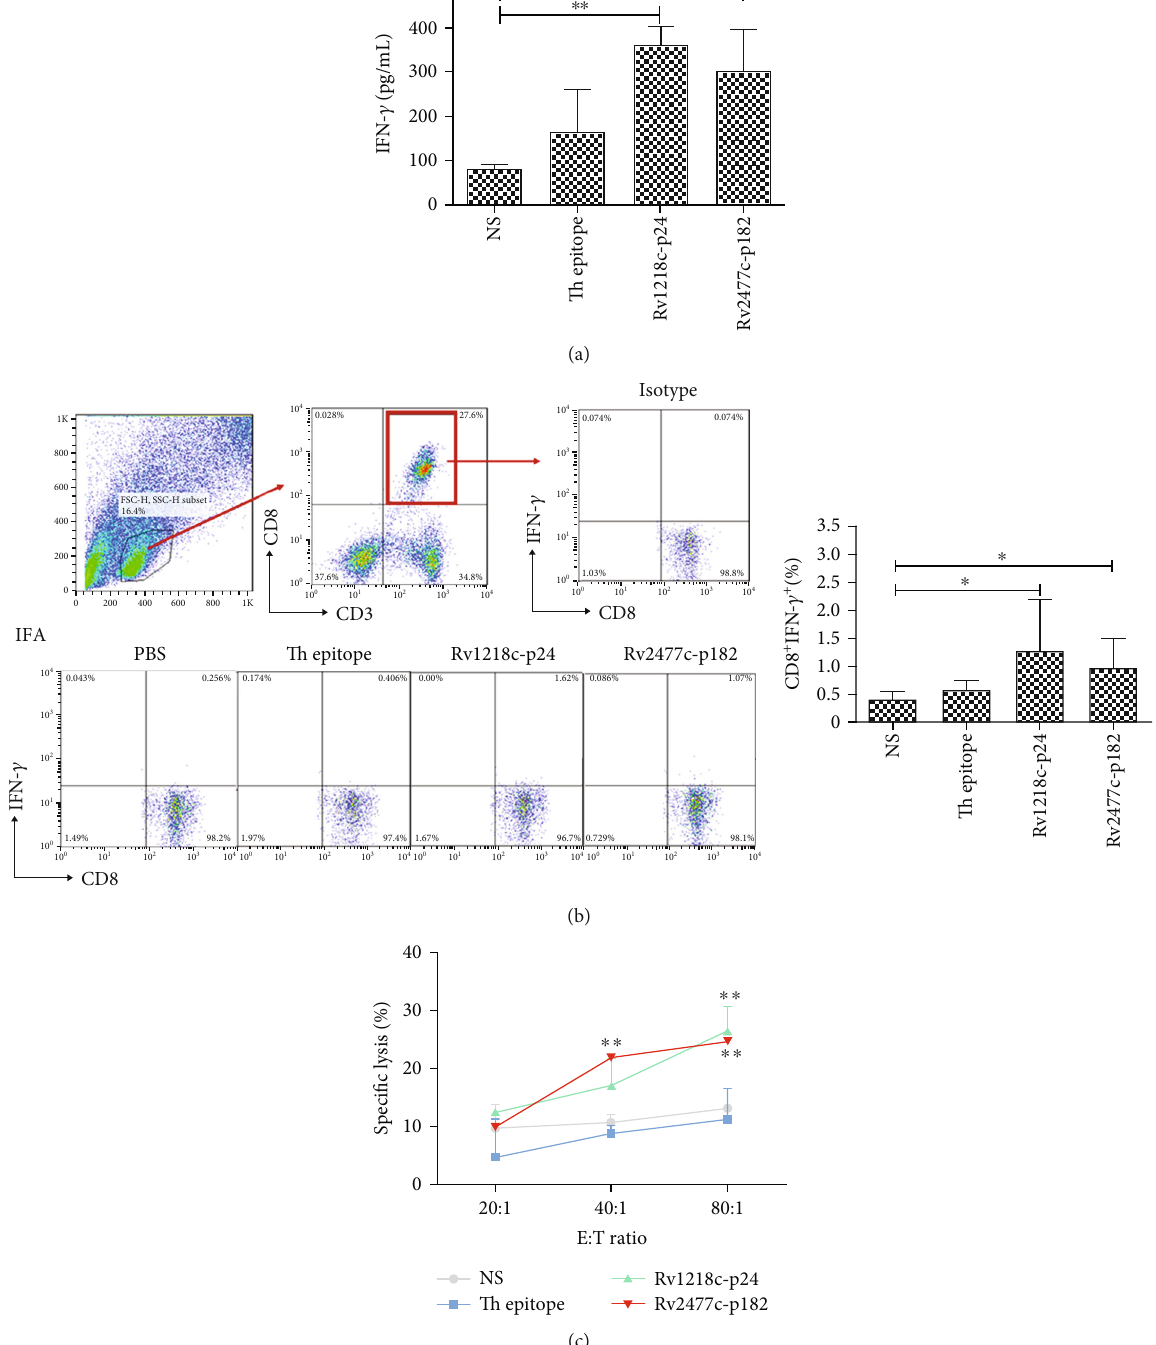
Figure 4: Activity of CTLs induced with IFA-emulsi fi ed peptide in HLA-A2.1/K b transgenic mice. HLA-A2.1/K b transgenic mice ( n = 5 ) were subcutaneously immunized at the base of the tail with each peptide (100 μ g/mice) and T helper epitope (140 μ g/mice) emulsi fi ed with incomplete Freund ’ s adjuvant (IFA) at 1 :1, three times (on days 0, 5, and 10). On day 11, all the mice were sacri fi ced and the serum was collected from each mouse to measure the IFN- γ concentration with an ELISA assay (a). The splenic lymphocytes were isolated from each mouse and restimulated once with each peptide (10 μ g/mL) and mIL-2 (10 U/mL) in vitro for another 6 days. On day 7, the IFN- γ release in each group was measured with an intracellular cytokine staining (ICS) assay (b) and the lysis activity was measured with an LDH assay (c). Peptide-loaded T2A2 cells were used as the target cells. Normal saline (NS) group and Th epitope only group were the negative controls. Statistical signi fi cance was determined with Student ’ s t -test ( n = 5 ). ∗ P < 0 : 05 and ∗∗ P < 0 : 01 represent the signi fi cance of di ff erences relative to the NS